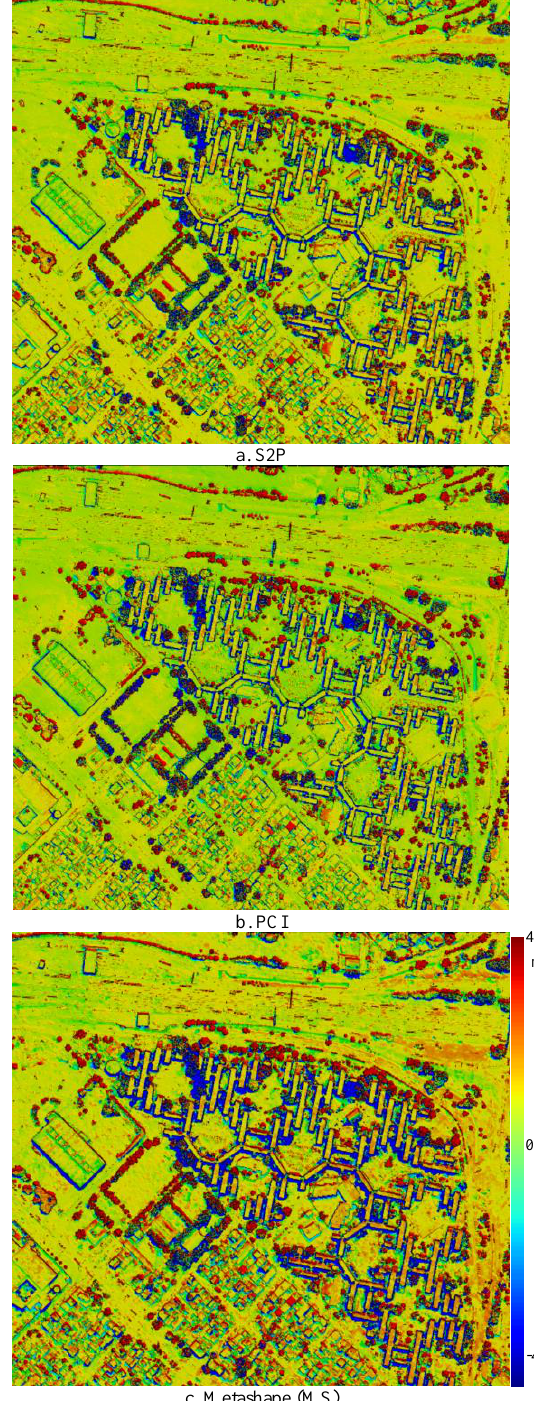
c. Metashape (MS) Figure 4. Error distribution map of the computed DSMs from considered solutions (red and blue indicate the largest distance). As is shown in Figure 5(a), green, red, and yellow masks indicate three areas of interest, where the green masked area is charactered with low-rise residential buildings, the red masked area is charactered with high-rise buildings arranged in octagonal patterns, and the yellow masked area is the road/bridge. We give the cross-section analysis in Figure